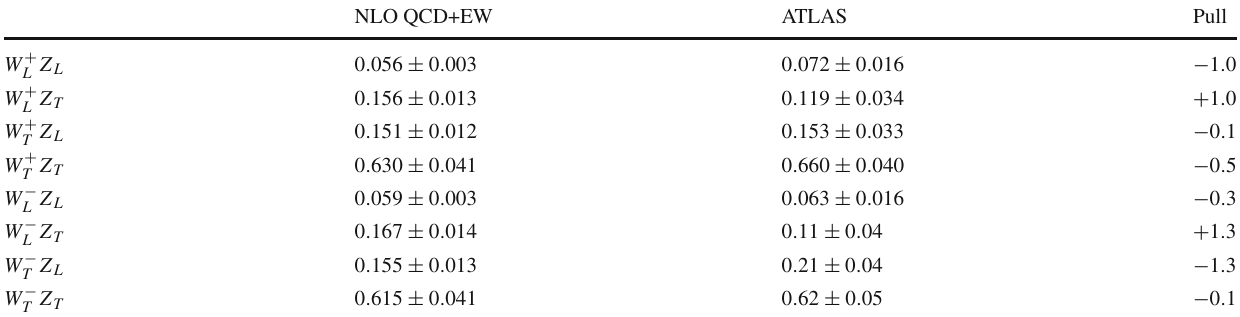
Table 2 Comparison with ATLAS measurements [28] for the polarization fractions. The pull is defined as ( Theory − Experiment )/σ where σ is the combined error calculated in quadrature